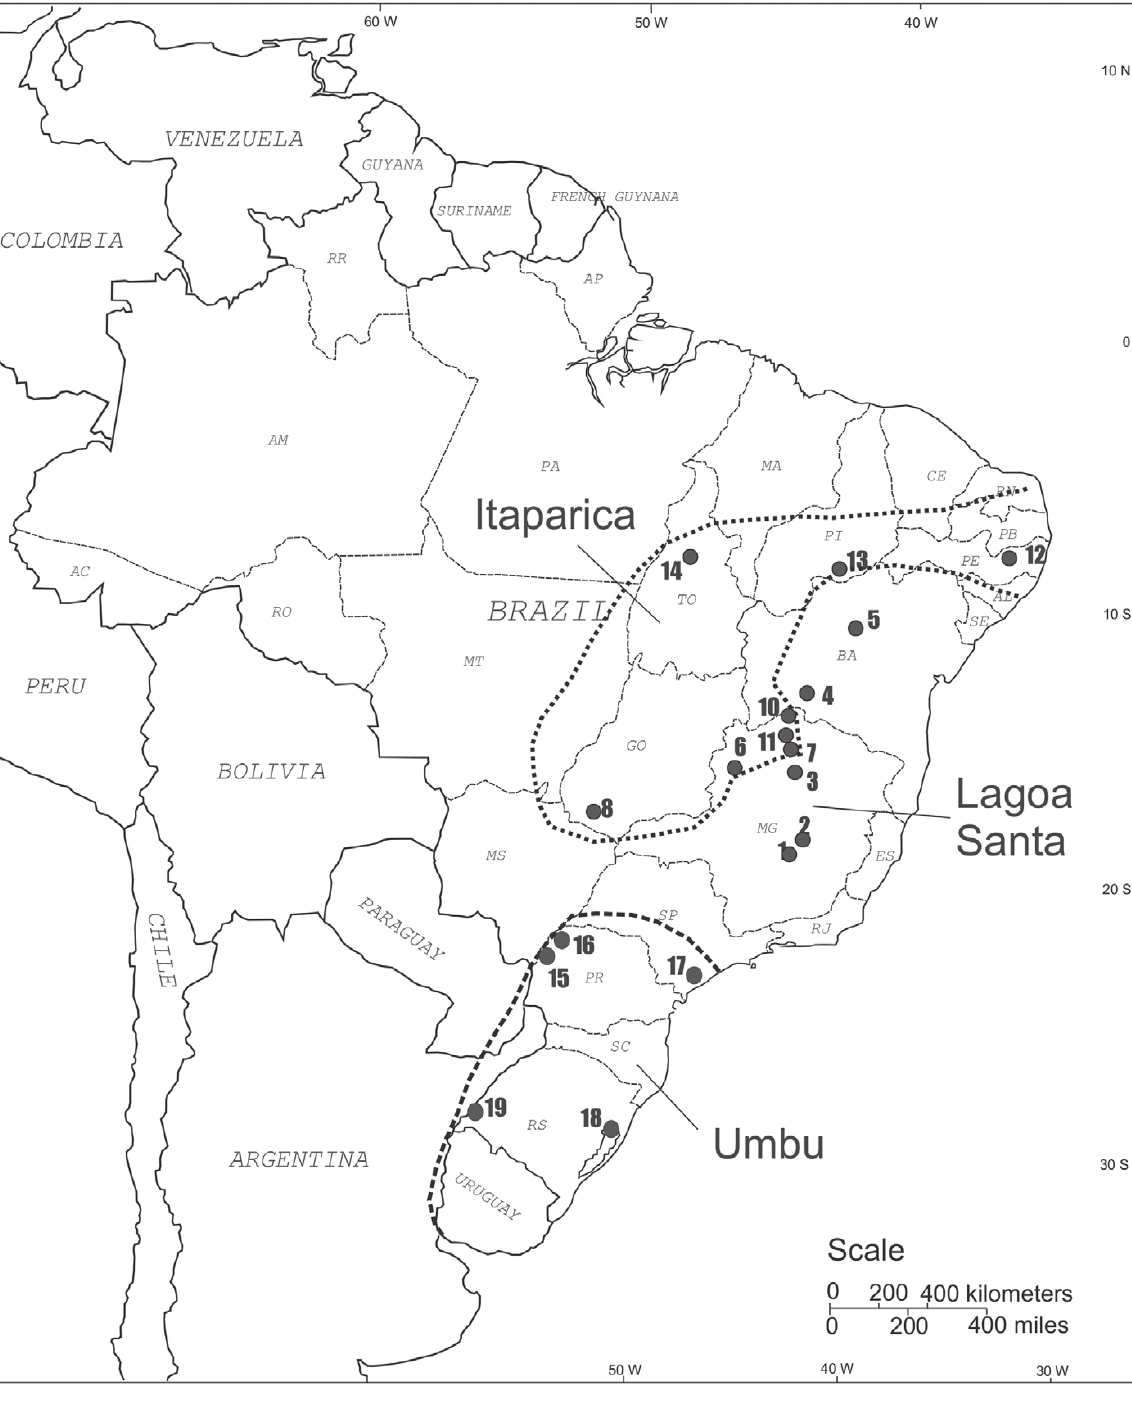
Figure 1 - Selected archaeological sites related to the eastern South America Paleoindian Traditions. Lagoa Santa: 1= Lapa do Santo, Boleiras and Taquaraçu; 2= Santana do Riacho; 3= Lapa Pequena; 4= BA-RC-28; 5= Abrigo do Pilão. Itaparica: 6= Gruta do Gentio II; 7= Lapa do Varal; 8= GO-JA-01; 9= MT-GU-01; 10= Lapa do Dragão; 11= Lapa do Boquete; 12= Furna do Estrago; 13= Pedra Furada (São Raimundo Nonato area);14= Lajeado. Umbu: 15= PR-FI-124; 16= PR-FI-138; 17= Capelinha; 18 = RS-C-43 and RS-S-327; 19=